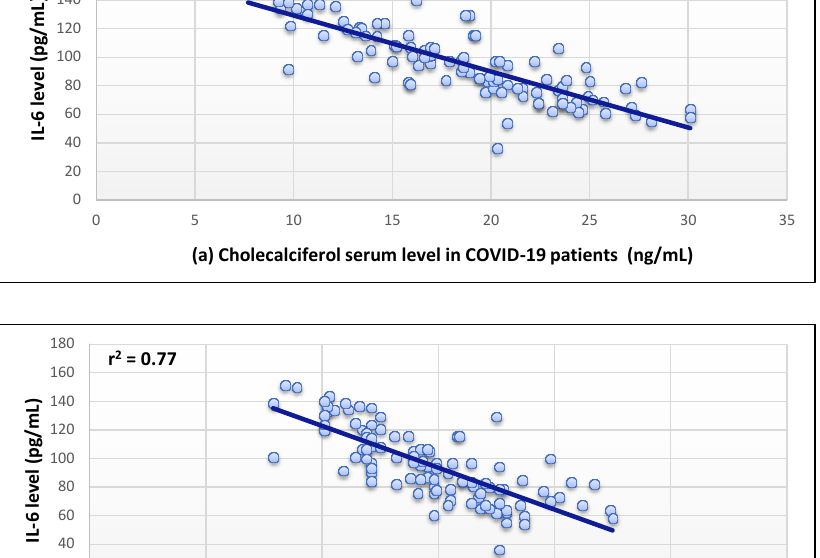
Figure 2. Correlation between the levels of angiotensin-converting enzyme 2 (ACE2) and ( a – c ) in COVID-19 patients. r 2 = 0.83